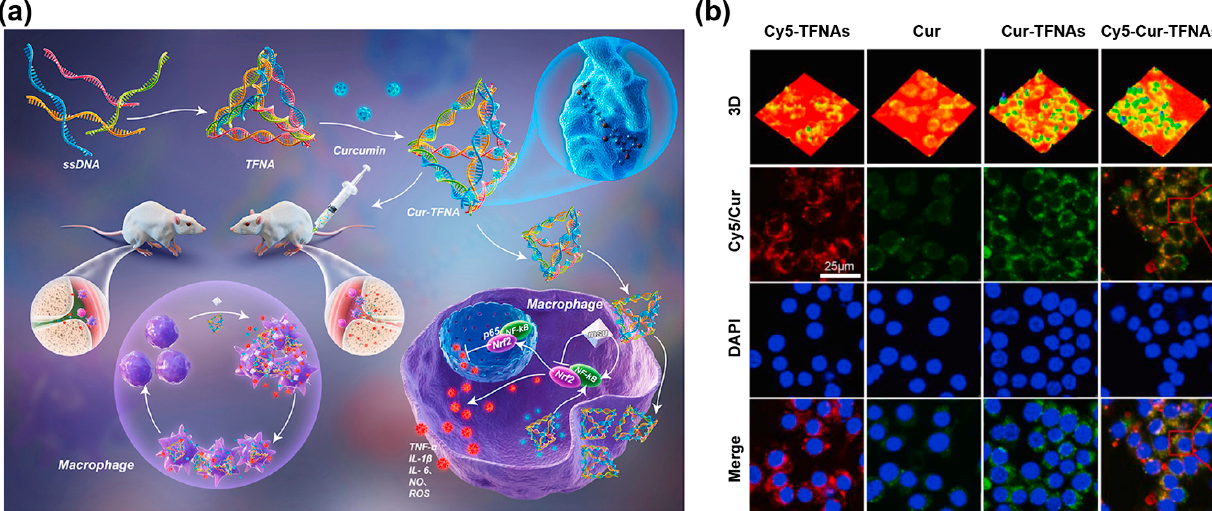
Figure 4. ( a ) Schematic illustration of acute gouty arthritis treatment with Cur-TFNAs. ( b ) Cellular uptake of Cy5-TFNAs, Cur, Cur-TFNAs, or Cy5-Cur-TFNAs in RAW264.7 cells. Reproduced with permission from [90], Copyright 2022,